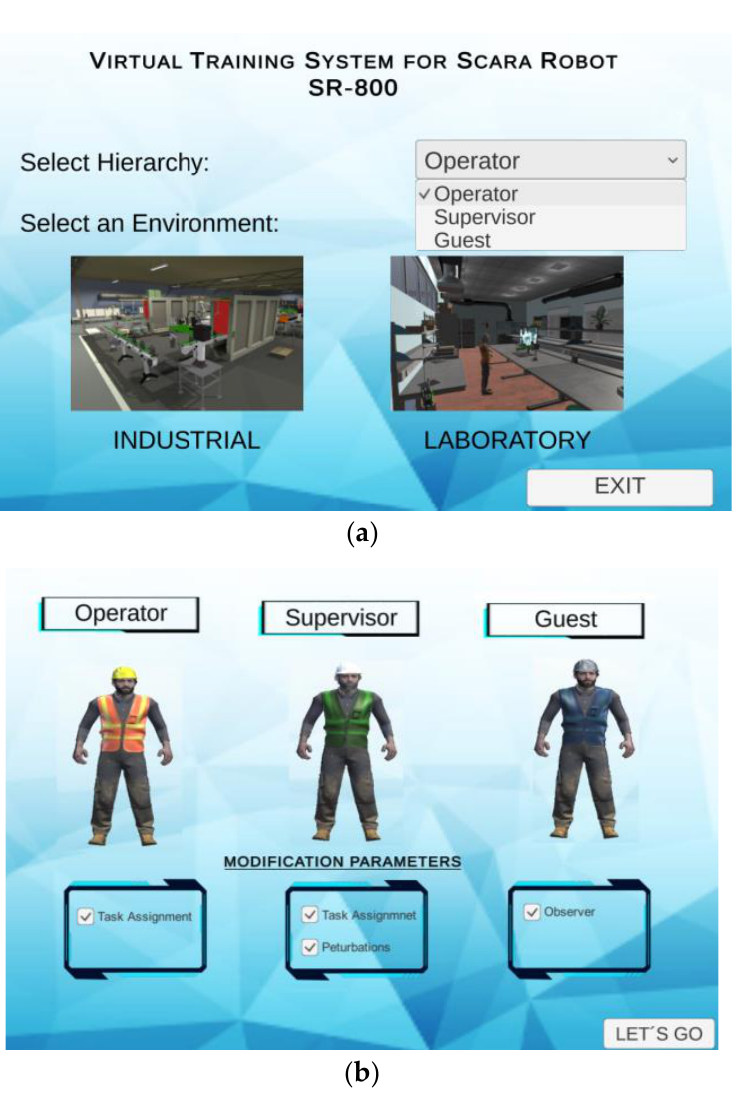
Figure 8. Operability interface for virtual laboratory and industrial training system.( a ) Operating interface of the virtual training system. ( b ) User selection interface according to hierarchy level.